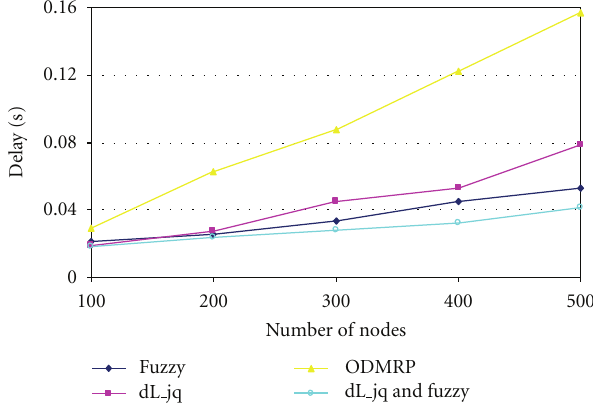
Figure 10: Overall overhead per a data packet.